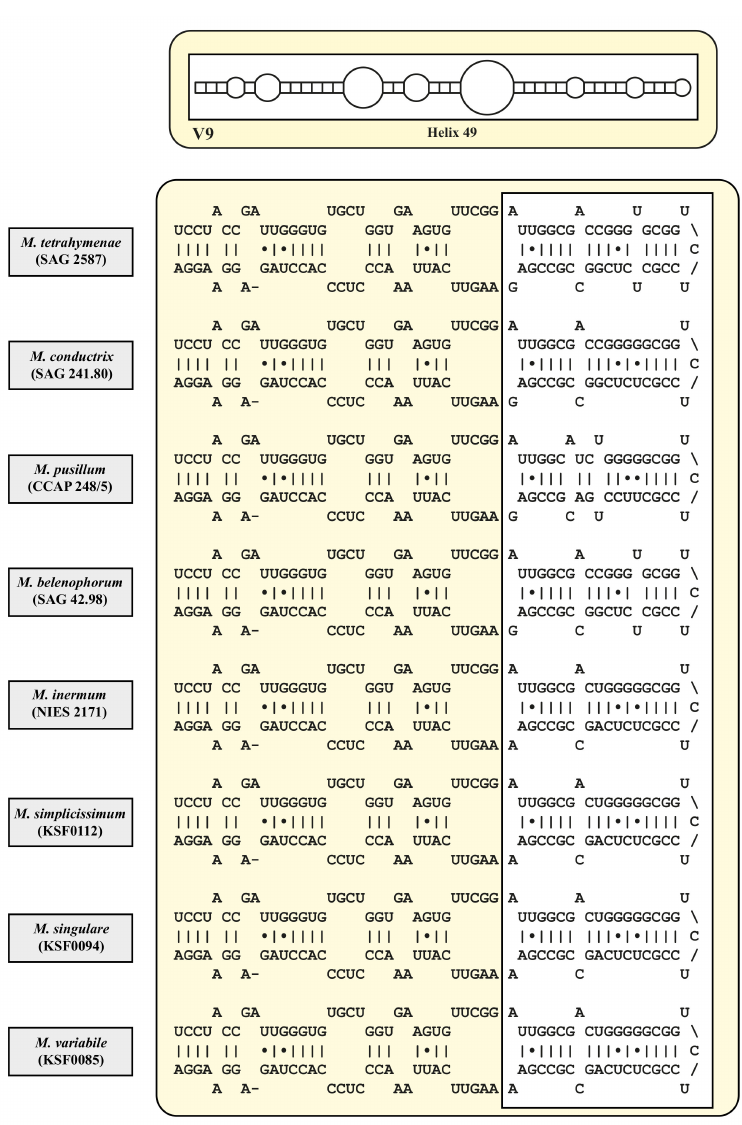
Figure 3. Molecular phylogeny of the Chlorellaceae based on SSU and ITS sequence comparisons. The phylogenetic trees shown were inferred using the maximum likelihood method based on the data sets (2602 aligned positions of 40 taxa), using PAUP 4.0a167. For the analyses, the best model was calculated by PAUP. The setting of the best model was given as follows: GTR + I + G (base frequencies: A 0.2112, C 0.2784, G 0.2743, T 0.2361; rate matrix A-C 0.7316, A-G 0.9716, A-U 0.9475, C-G 0.6216, C-U 3.2173, G-U 1.0000) with the proportion of invariable sites (I = 0.7266) and gamma shape parameter (G = 0.6963). The branches in bold are highly supported in all analyses (Bayesian values > 0.95 calculated with MrBayes and PHASE, 10 million generations; bootstrap values > 50%, calculated with PAUP, 1000 replicates using maximum likelihood, neighbor-joining, and maximum parsimony). The endosymbiotic species are marked with a green circle. The accession and strain numbers are